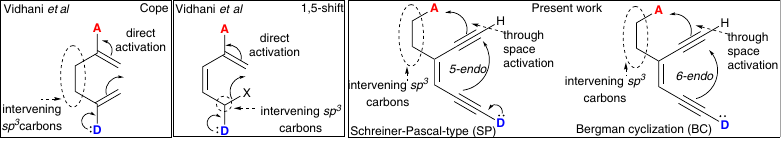
Fig. 10 FLP-mediated Cope, 1,5-sigmatropic shift, and ionic-Bergman cyclization. Groups A and D correspond acceptor and donor, respectively.